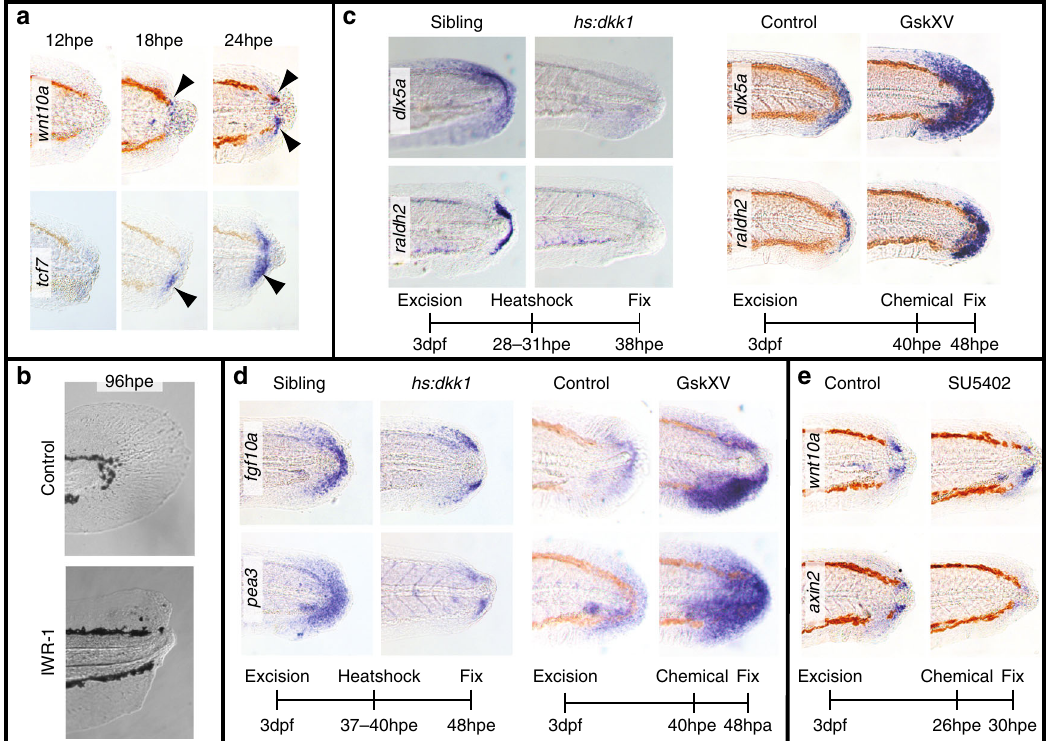
Fig. 2 Wnt/ β -Catenin signalling is required for patterning during larval regeneration. a Expression of the Wnt ligand, wnt10a , and the downstream target, tcf7 , become evident by 18 hpe (arrowheads) ( wnt10a /18 hpe 7/8, wnt10a /24 hpe 10/10, tcf7/ 18 hpe 9/10, tcf7/ 24 hpe 10/10, number of experiments = 2). b Larvae treated with 10 μ M IWR-1 continuously after excision show no signs of regeneration at 96 hpe (10/10 number of experiments = 2). c Heterozygous hs:dkk1 fi sh and their siblings were heatshocked by placing in an incubator at 39 °C and sorted based by fl uorescence present in the transgenic line. Non fl uorescent fi sh served as control fi sh. The GskXV treatments were done at 10 μ M ( hs:dkk1/dlx5a 10/10, hs:dkk1/raldh2 10/10, number of experiments = 2) (GskXV /dlx5a 10/10, GskXV /raldh2 10/10, number of experiments = 4). d Expression of fgf10a and pea3 are downregulated in hs:dkk1 larvae (treatment as in panel c ) and upregulated in fi sh treated with 12.5 μ M GskXV ( hs:dkk1 10/12 control, 28/30 transgenic, number of experiments = 2) (GskXV control 12/12, treated 11/12 number of experiments = 2). e Expression of the Wnt/ β -Catenin target gene axin2 is reduced in fi sh treated with 10 μ M SU5402 (12/12, number of experiments =